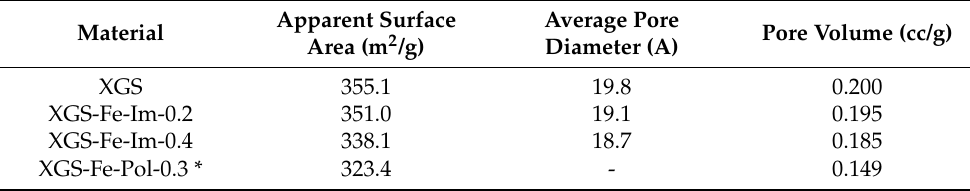
Table 2. Textural properties of the different XGSs. Material